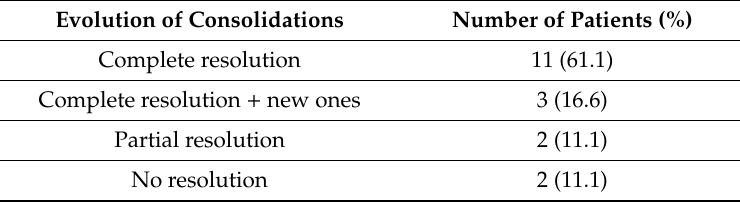
Figure 10. On the left ( a ): baseline HRCT; left parenchymal consolidations with air bronchogram sign in the context (arrowheads). On the right ( b ): HRCT after steroid treatment; new ground-glass areas (arrowheads) have appeared in the site of consolidations. Table 6. Evolution of the 15 patients who presented ground-glassopacities. Evolution of Ground-Glass Opacities Number of Patients (%) Complete resolution